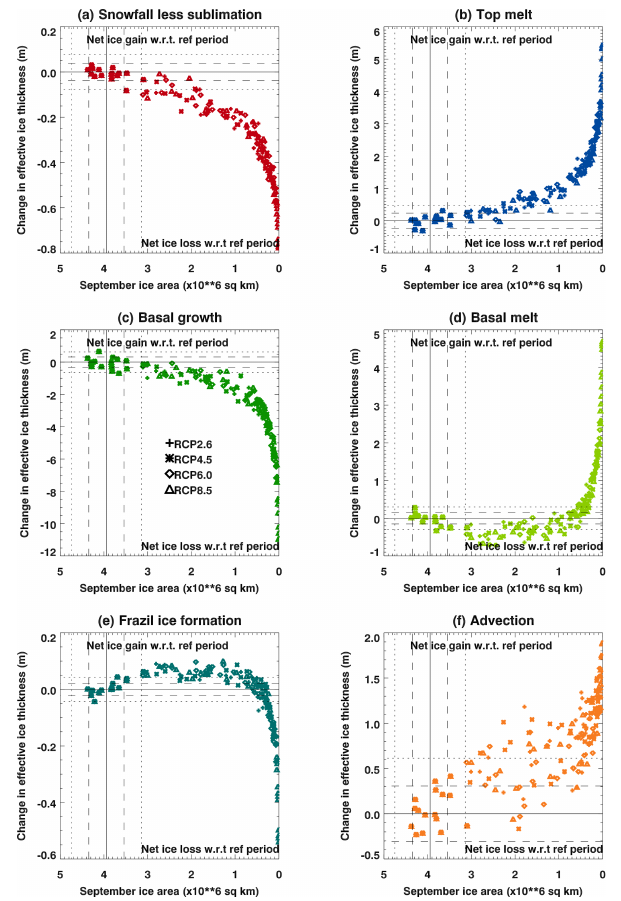
Figure 10. As in Fig. 9 but plotted against decadal mean September ice area rather than the decadal mean over all